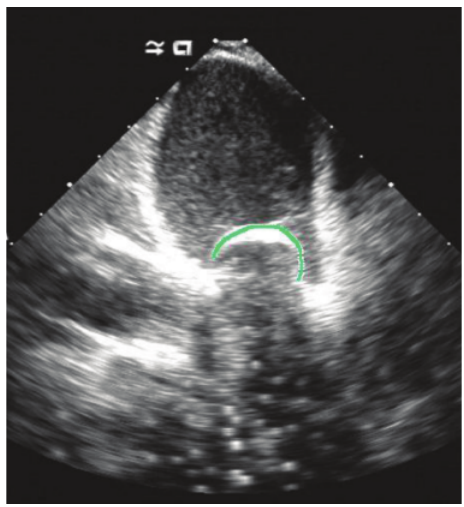
Figure 2: An intracardiac echocardiographic image demonstrates total occlusion of left superior pulmonary vein by cryoballon